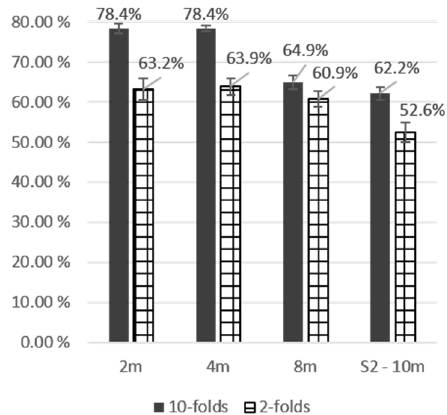
Figure 3. Comparison of results (OA) of 2-folds and 10-folds methods for the “species” nomenclature with the MNF DR.